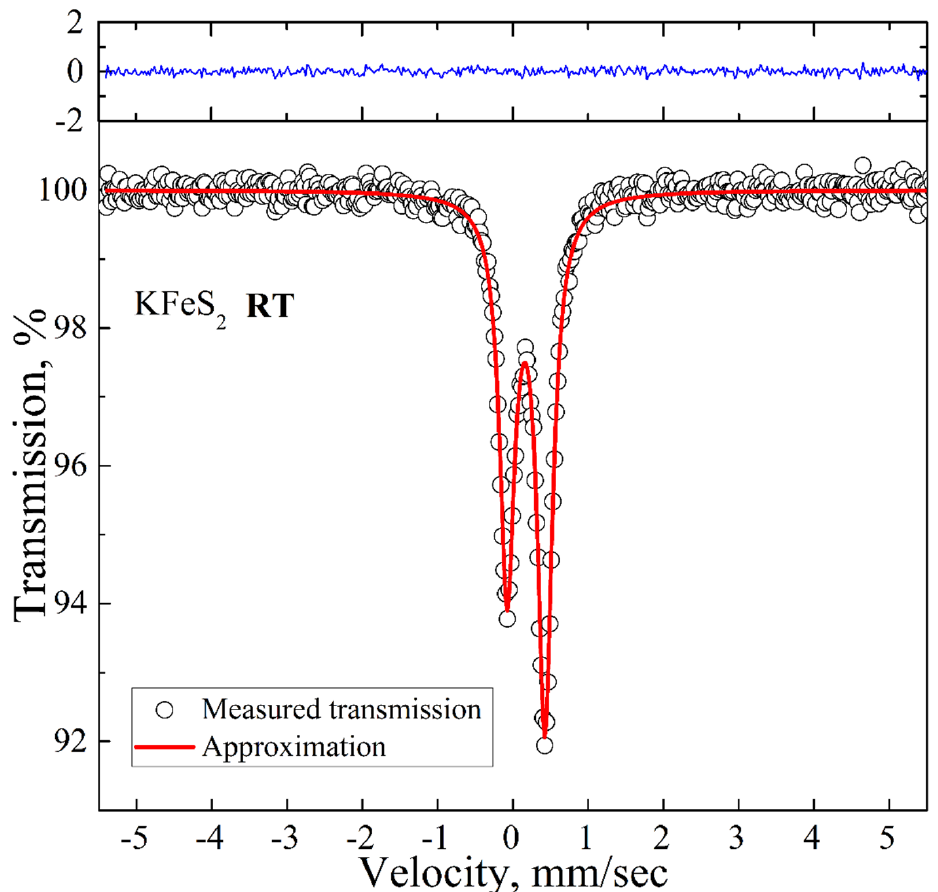
Figure 3. Room temperature 57 Fe Mössbauer spectrum of KFeS 2 (empty circles). Solid red lines represent the best fitting of the spectrum obtained by the least-squares fit (red line) under the assumption that the line shapes are Lorentzian. The blue line represents the difference between the measured spectrum and the fit.